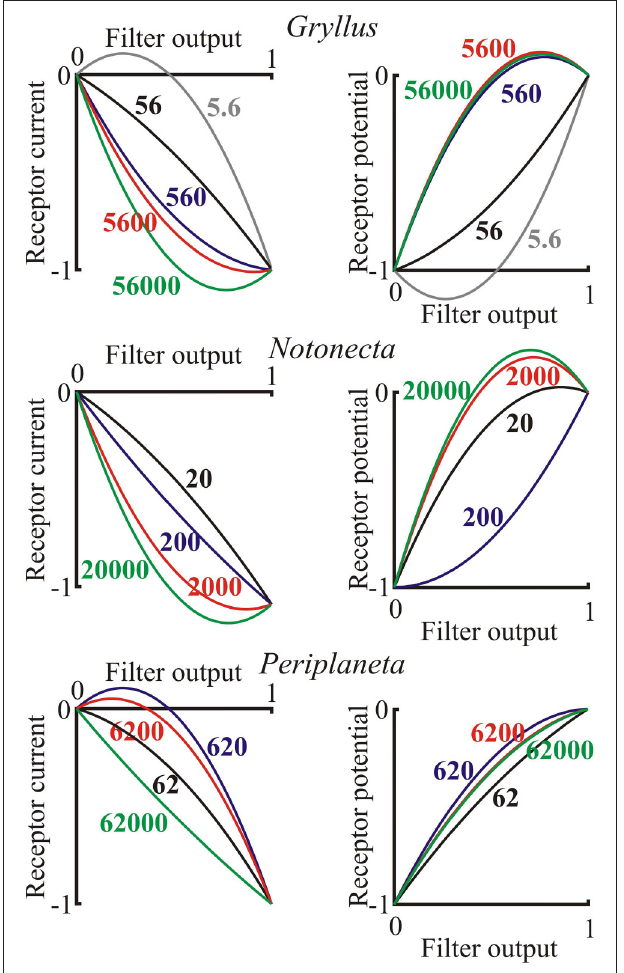
FIGURE 6 | Nonlinear functions representing the final stage of the photoreceptor model (Figure 1) for both receptor current and receptor potential. Axes were normalized to the output range of the filter function, as input, and the final current or potential range as output. Data are shown for single examples of the three species as functions of the input light intensity in effective photons per second, indicated on each curve. Note, that these are only second-order polynomials, so output values exceeding the inputs in some cases are only approximations to the final nonlinearity, which would probably be reduced by higher order terms.